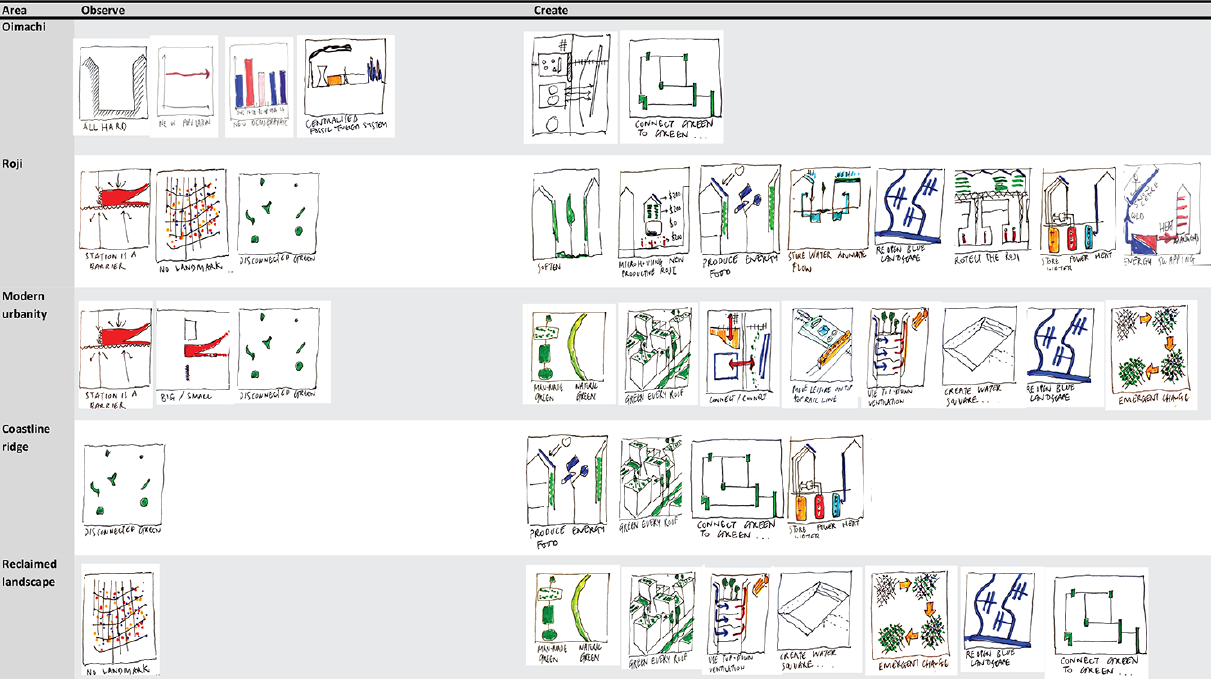
ways are connected by the orthogonal system in the urban modernity area, creating a spatial framework for this rapidly changing environment. Within this basic framework of the lower dynamic uses such as green, ecology and water, new and temporal uses with higher